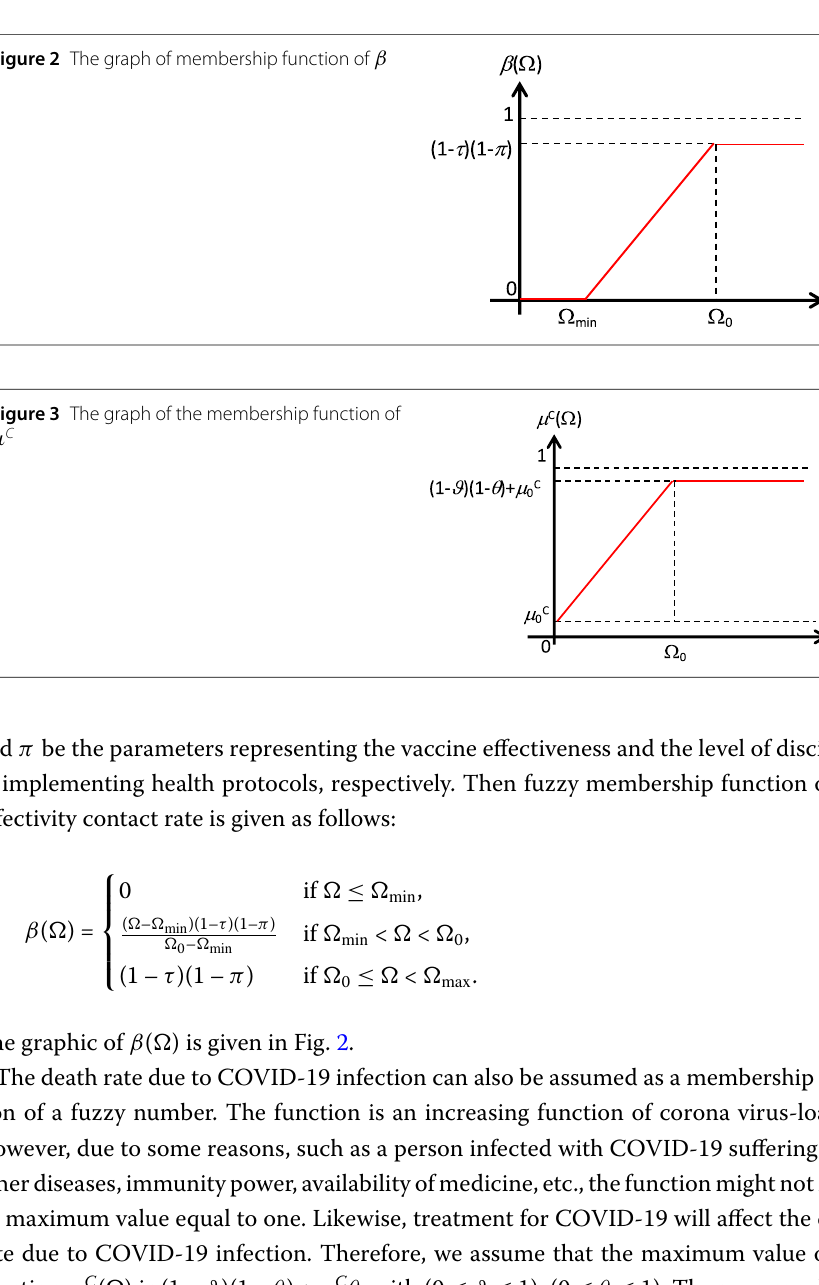
Figure 2 The graph of membership function of β